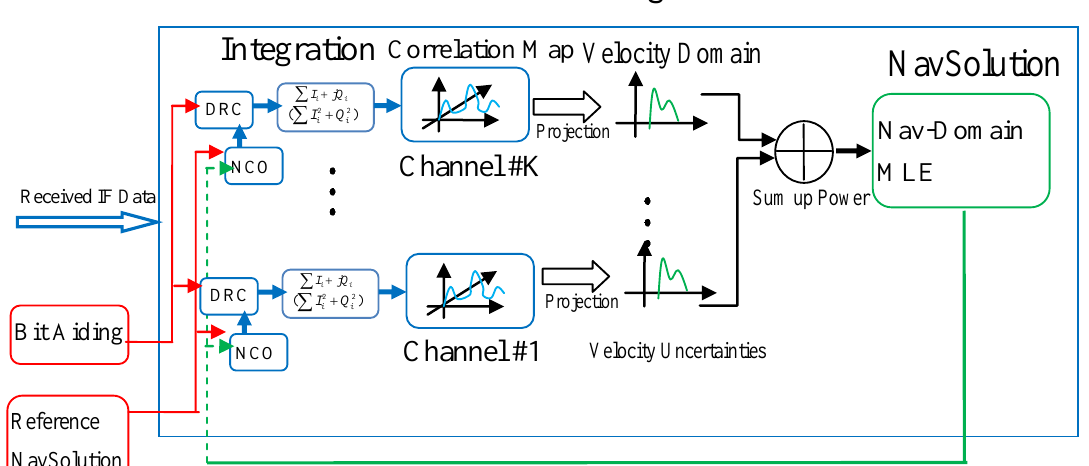
Figure 2. Direct vector GNSS receiver